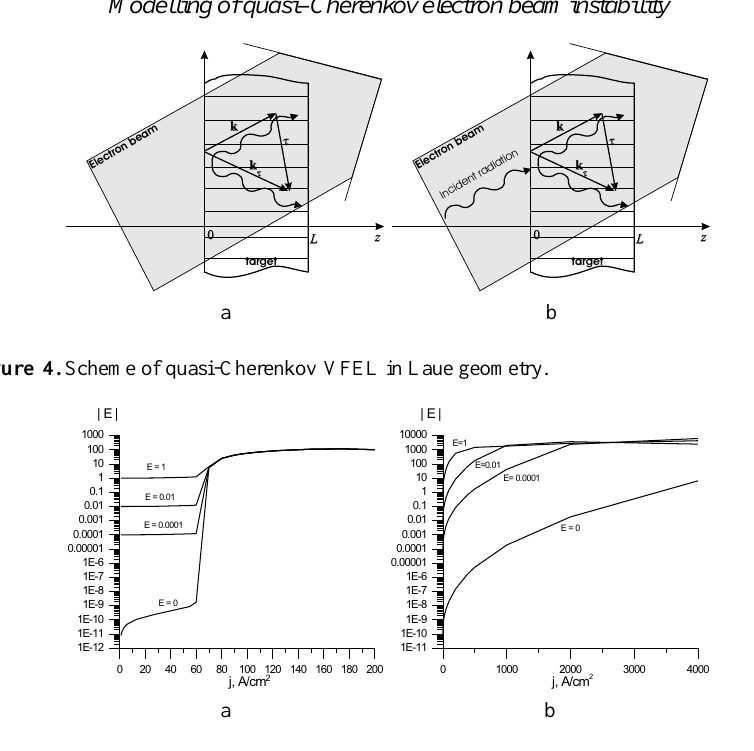
Figure 5. Dependence between computed electromagnetic wave amplitude and electron beam current density in Bragg (a) and Laue (b)